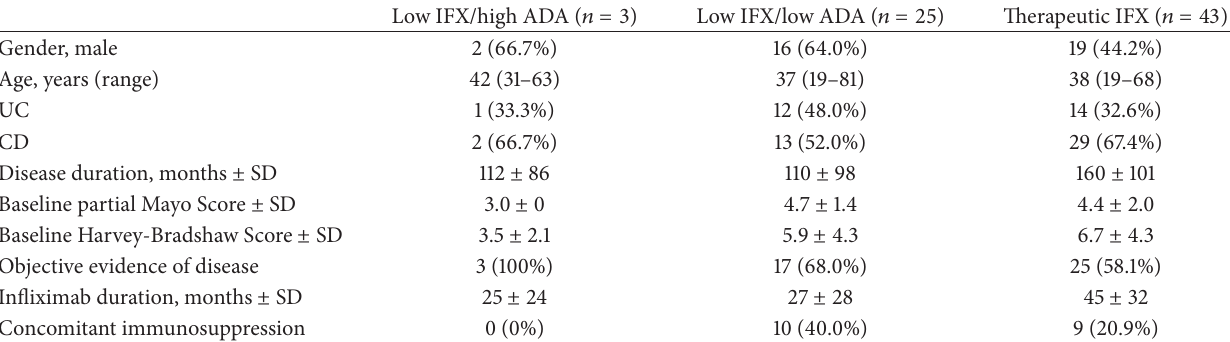
Table 1: Characteristics of inflammatory bowel disease patients on infliximab with concerns for loss of response at time of therapeutic drug